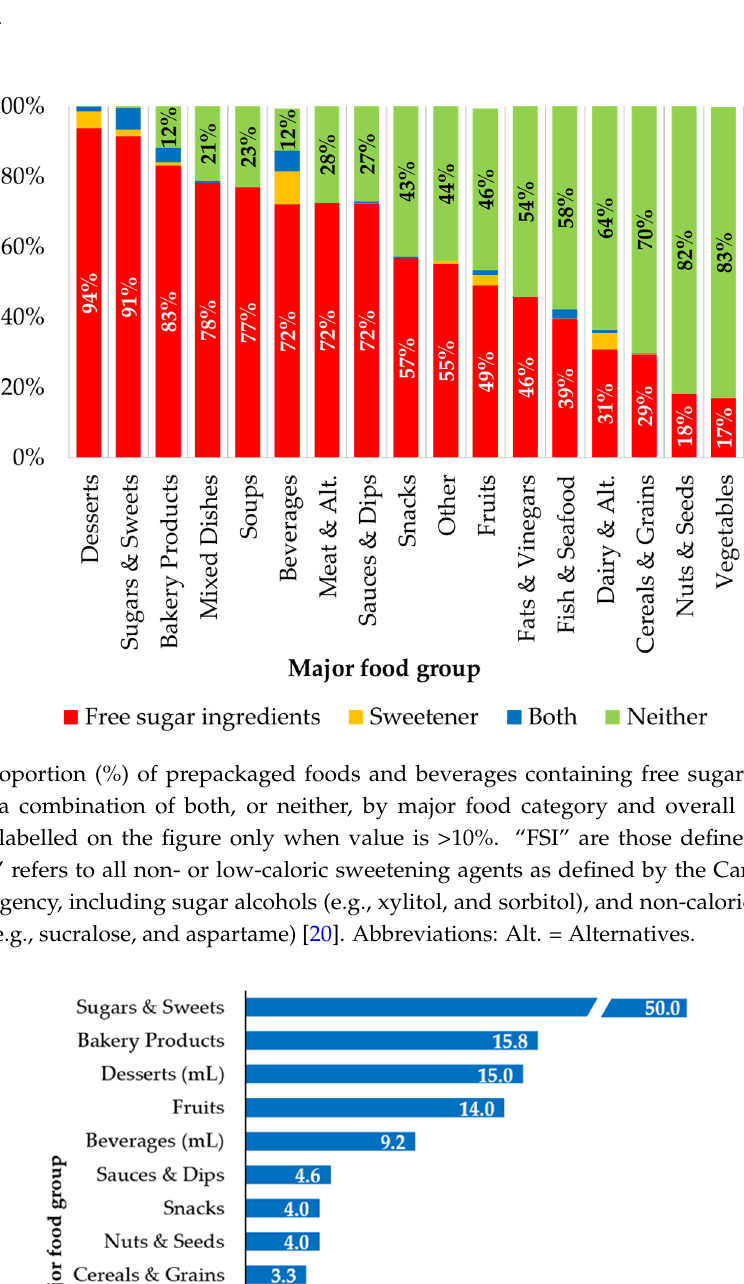
Nutrients 2016 , 8 , 582